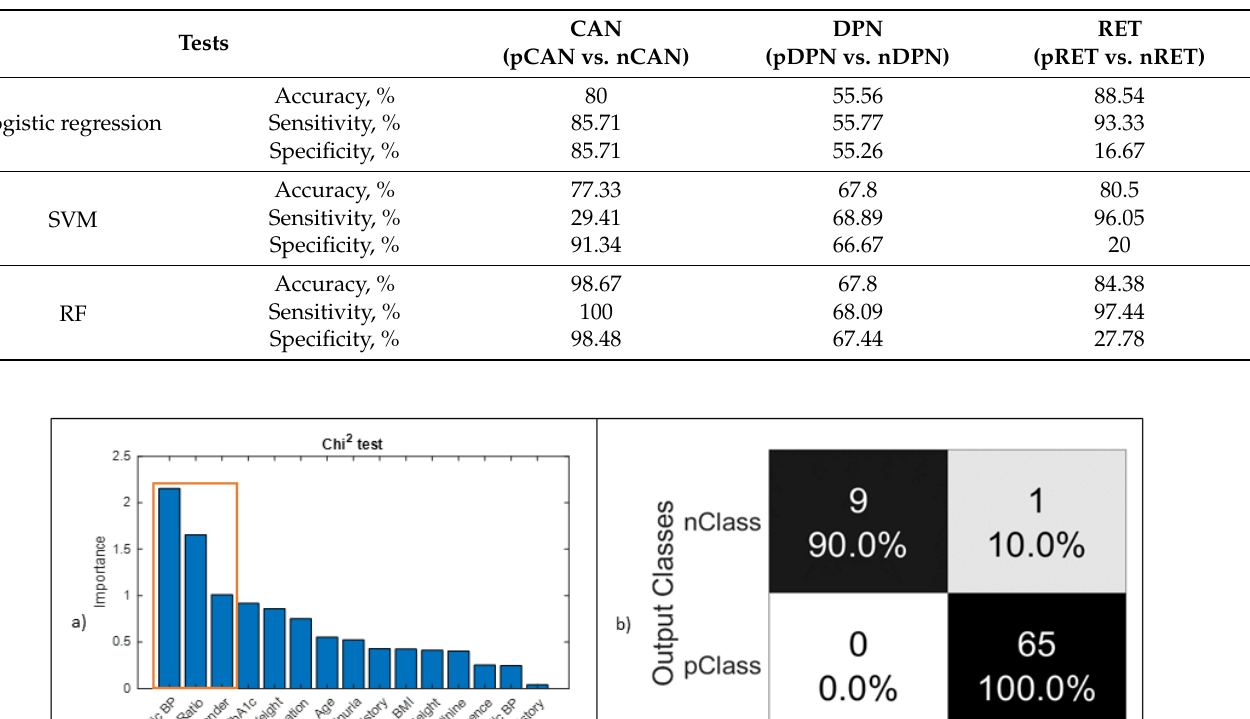
Table 6. 95% Confidence intervals for cardiac autonomic neuropathy patients (categorical features, such as gender, smoking history, and smokeless tobacco history, have been omited from the table);. The subject count is 75 (65 pCAN, and 10 nCAN patients), and the features that are used in the model classifier are marked in bold text. Table 5. Comparison between two machine learning models for each test.